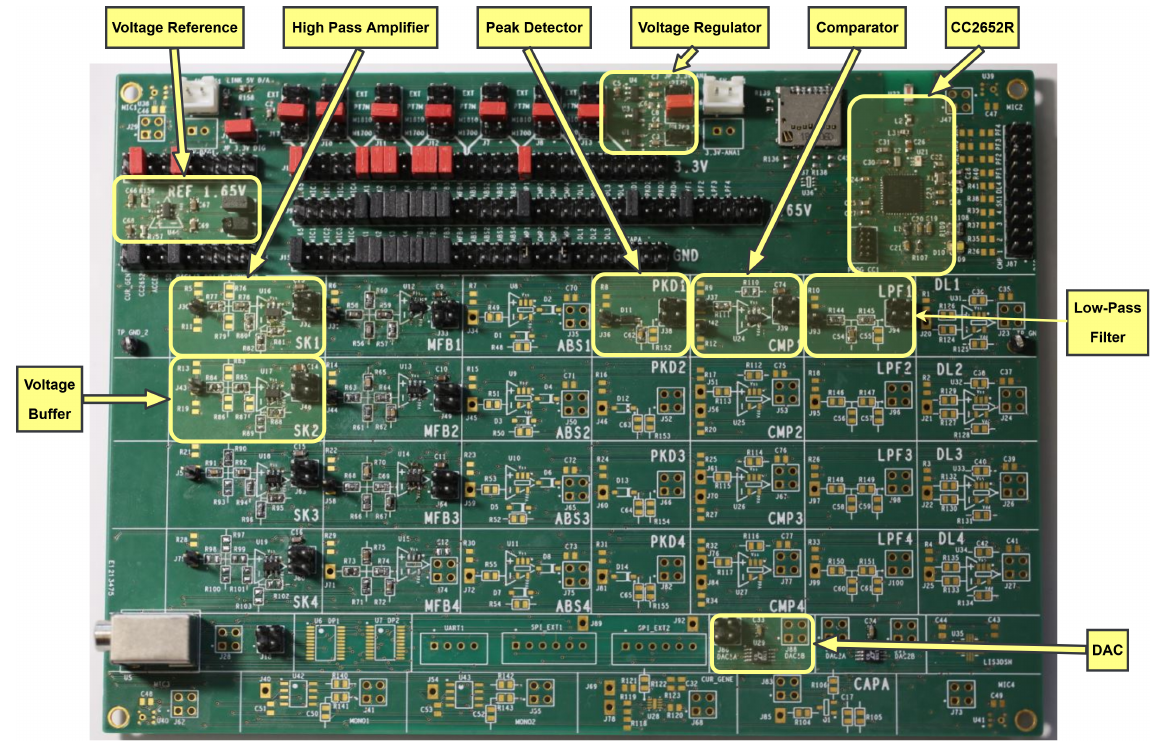
Figure 13. Analog test and power measurement